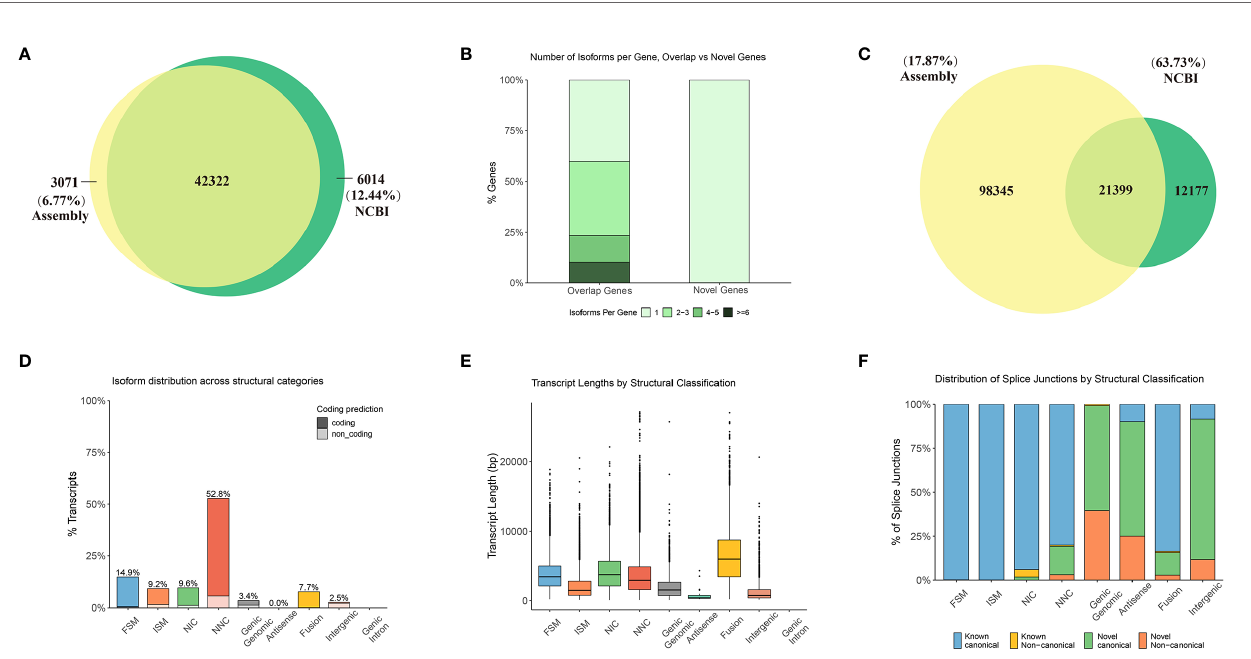
FIGURE 3 | Further detailed annotation of the common carp genome through the transcriptome of the testes and the brain at different developmental stages. Venn diagram depicting 42,322 overlapping genes between the NCBI data and the assembly. (A) Venn diagram of the number of gene annotations comparisons between assembly and NCBI data. (B) Number of isoforms per gene in overlapping and novel genes. (C) Venn diagram of the number of transcript annotations between the assembly and NCBI data. (D – F) Characteristics of the annotated transcripts. FSM, full splice match; ISM, incomplete splice match; NIC, Novel in catalog; NNC, Novel not in catalog. (D) Isoform distribution across structural categories. (E) Transcript lengths by structural classi fi cation. (F) Distribution of splice junctions based on structural classi fi